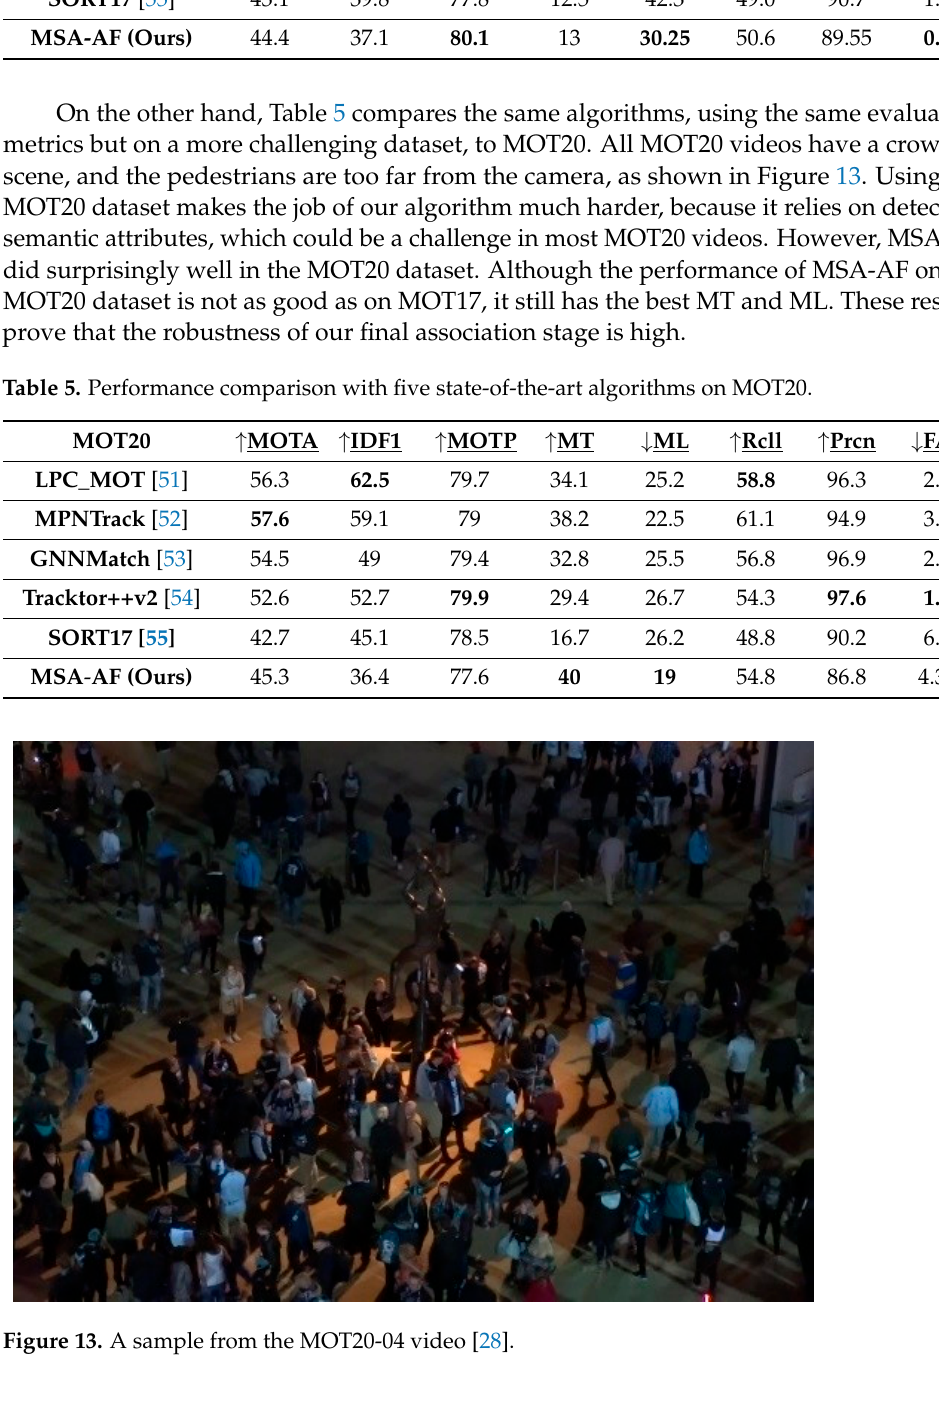
Table 4. Performance comparison with five state-of-the-art algorithms on MOT17.